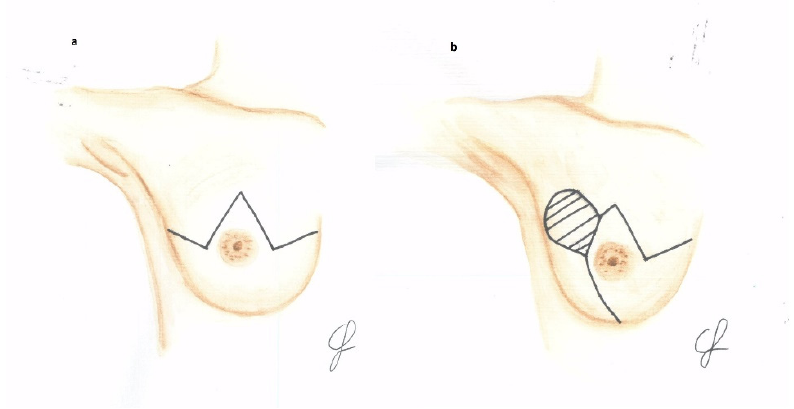
Figure 2. Preoperative markings: ( a ) Wise skin excision pattern; ( b ) modified-Wise skin excision pattern; dashed area shows the upper quadrant that has to be removed.